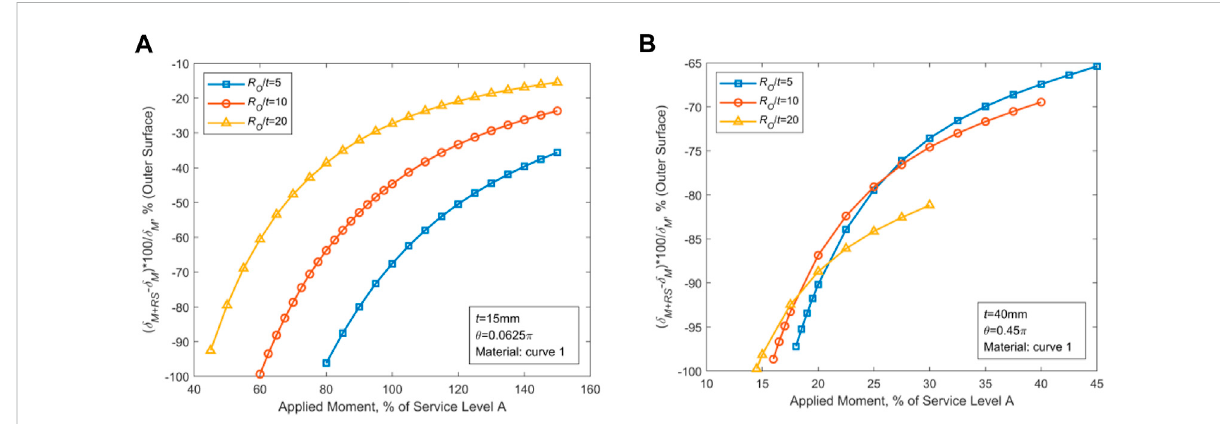
FIGURE 6 Effect of WRS on the outer wall ’ s COD. (A) Effect of WRS on thin-walled piping. (B) Effect of WRS on thick-walled piping.